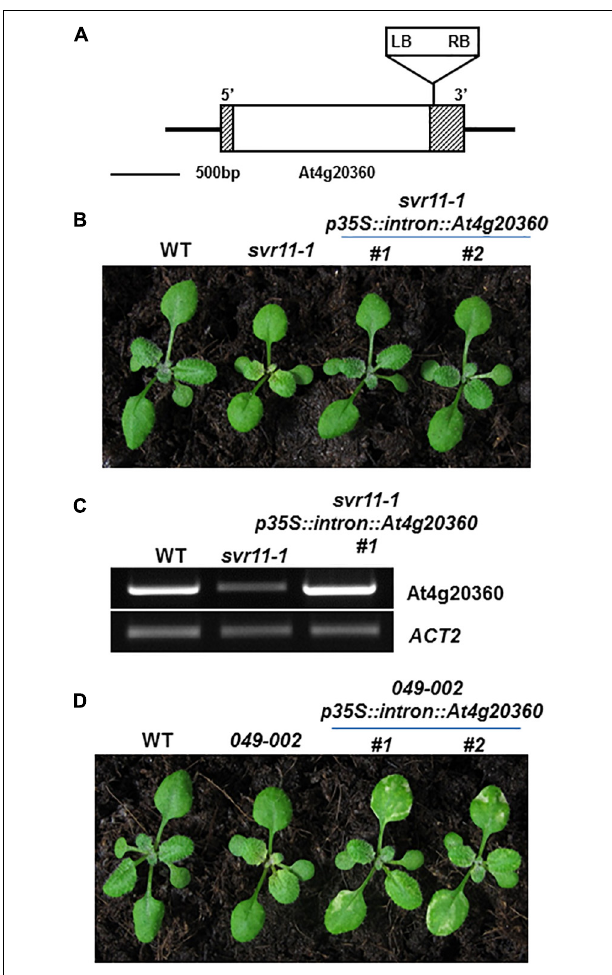
FIGURE 2 | Cloning of SVR11 and complementation of svr11-1 . (A) A T-DNA insertion was identified in the 3 (cid:48) -UTR of At4g20360 by inverse PCR. The left border (LB) and the right border (RB) were indicated. Gray boxes and the white box represent UTRs and the exon, respectively. (B) Representative 2-week-old wild-type, svr11-1 and svr11-1 p35S::intron At4g20360 (constitutive expression line of At4g20360 in svr11-1 background). (C) The accumulation of At4g20360 transcripts was indicated by semi-quantitative RT-PCR. The semi-quantitative RT-PCR was repeated three times. (D) Representative 2-week-old wild-type, 049-002 and 049-002 p35S::intron At4g20360 (constitutive expression of At4g20360 in 049-002